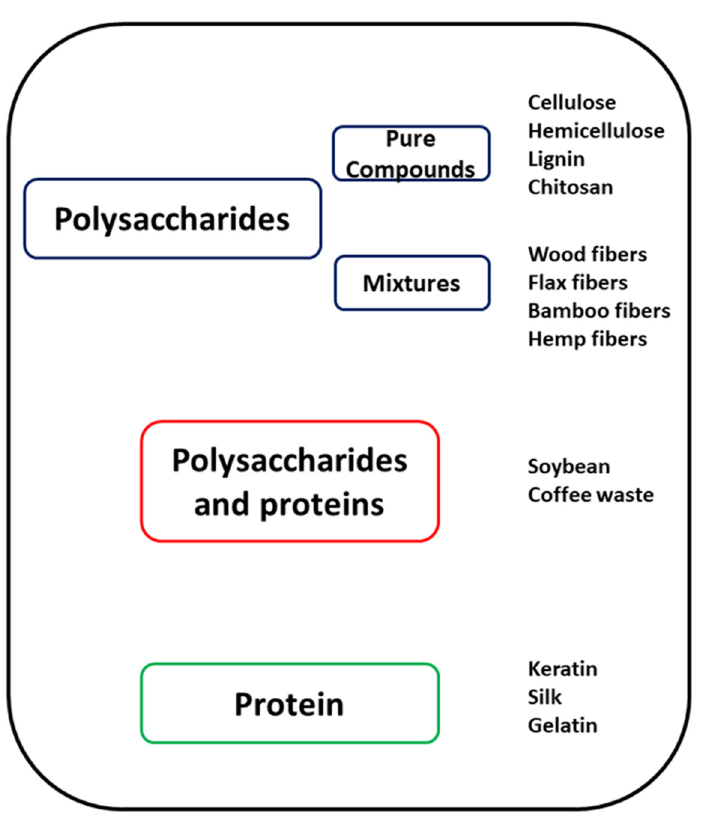
Figure 2. Scheme reporting the classification of the natural polymers discussed in the review as reinforcing agents for 3D printing.